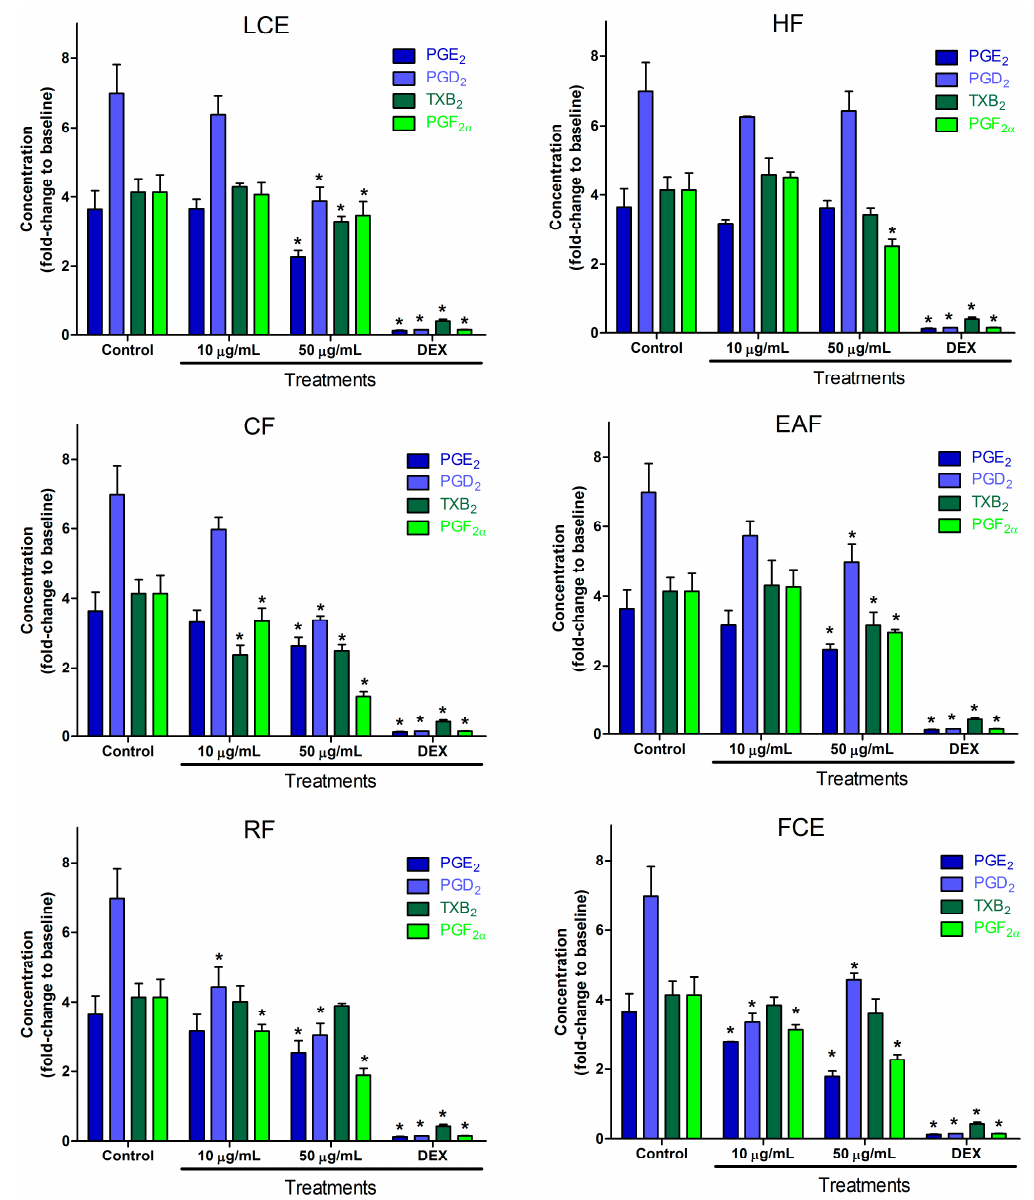
Figure 1. Effect of leaf crude extract (LCE), hexane fraction (HF), chloroform fraction (CF), ethyl acetate fraction (EAF), residual fraction (RF), and flower crude extract (FCE) of M. sylvestris on PGE 2 , PGD 2 , TXB 2 , and PGF 2 α production in LPS-stimulated RAW 264.7 cells. Cells were treated with LPS in the absence or presence of the fractions at two concentrations (10 and 50 μ g/mL). Dexamethasone (DEX) was used as positive control. After incubation, cell culture supernatants were harvested, and PGE 2 , PGD 2 , TXB 2 , and PGF 2 α production was determined. Values are expressed as mean ± SD. * p < 0.001 vs. control (LPS alone).